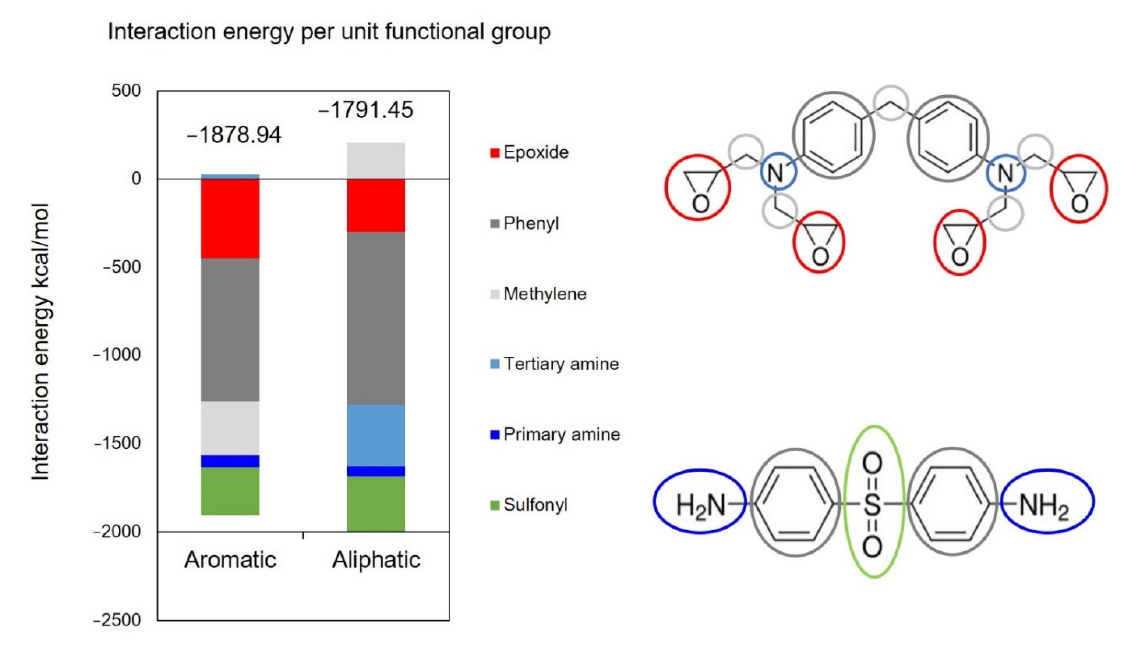
Figure 18. Interaction energy contribution by functional groups in the tetrafunctional epoxy system for the aromatic and aliphatic surfaces.